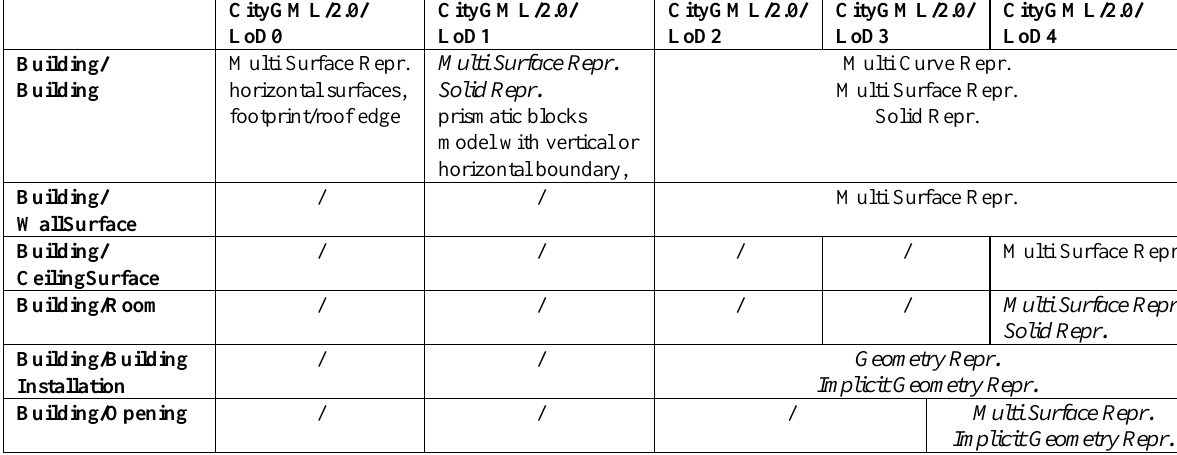
Table 1. Profiles for backward compatibility (for abbreviations and explanations see the remarks for Table 2 ). Geometry types in italics are used mutually exclusively in one profile. For each feature type of the building module, several profiles are defined. The table defines in total 28 profiles, the contextIdentifiers of which are a combination of a level name in the first row and a module/feature type name in the first